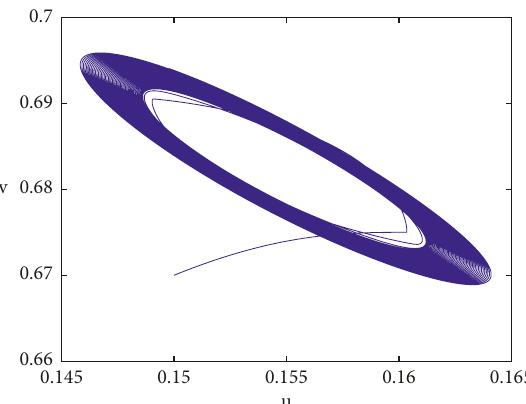
Figure 11: Phase diagram of system (9) at E ∗ ( u ∗ , v ∗ ) � ( 0 . 1549 , 0 . 6823 ) when D